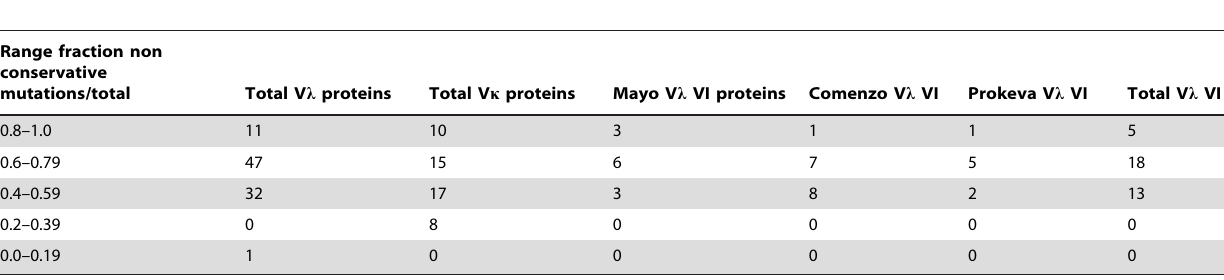
Table 1. Comparison of range of the fraction of non-conservative mutations/ total for all AL V l ,V k , Mayo, Comenzo and Prokaeva V l VI, and all V l VI proteins.